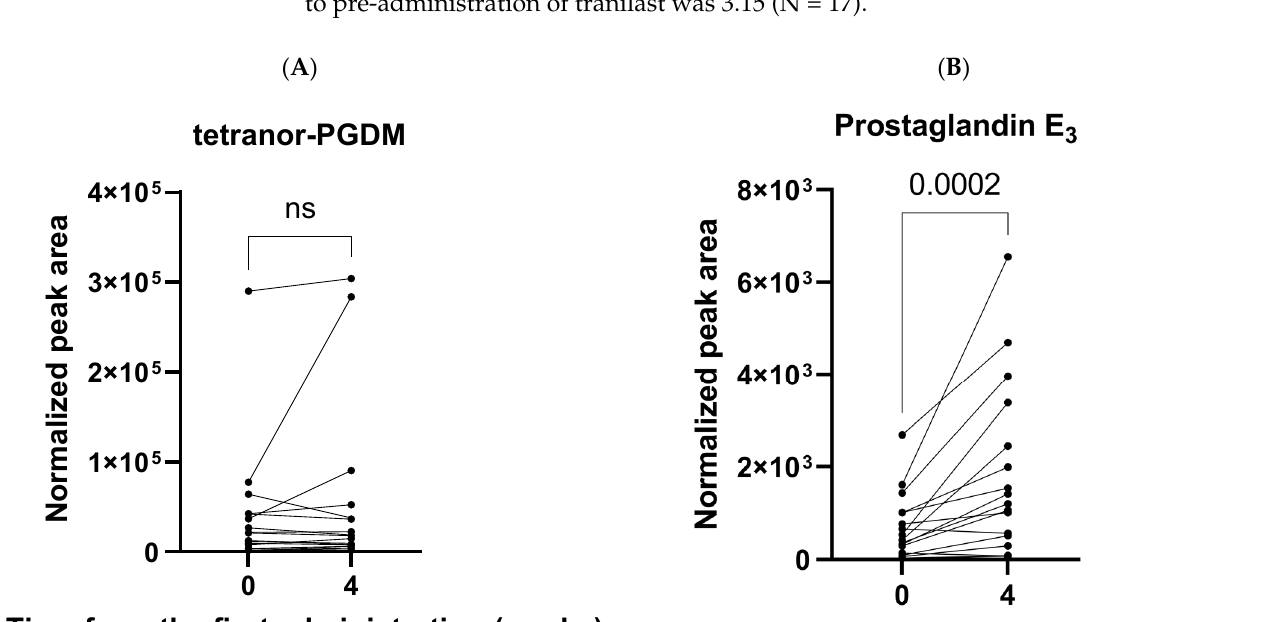
Figure 3. Comparison of normalized peak area of ( A ) tetranor-PGDM and ( B ) prostaglandin E 3 in 17 DMD patients between pre- and post-administration. p -values were determined using the Wilcoxon signed-rank test. ns, not significant.